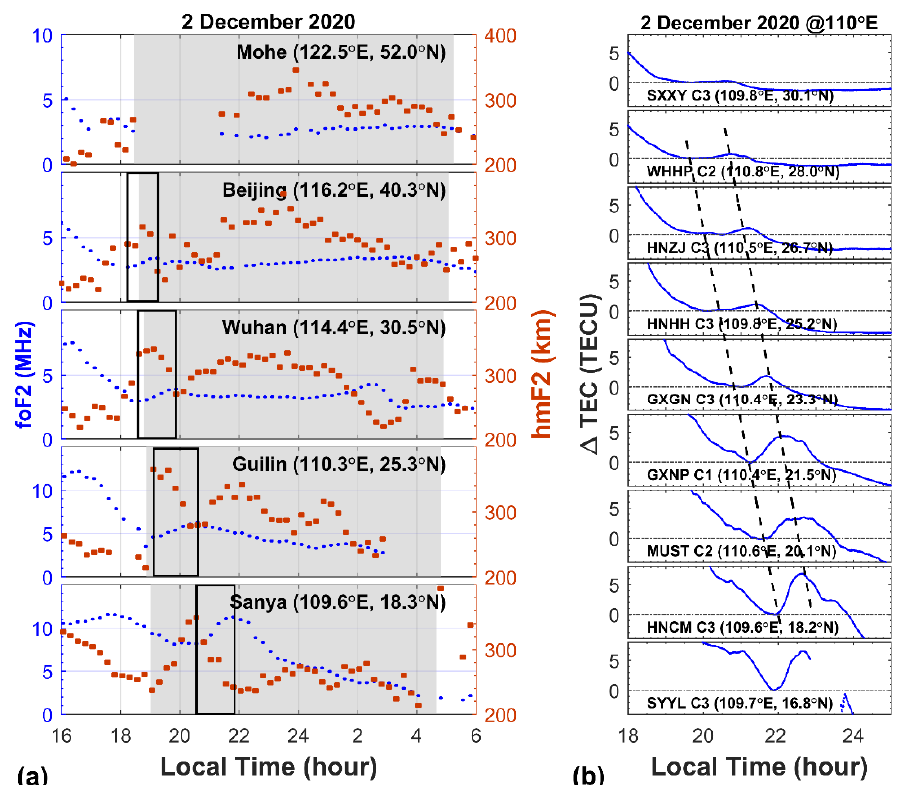
Figure 3. ( a ) Temporal variations of foF2 and hmF2 at Mohe, Beijing, Wuhan, Guilin, and Sanya within the time interval from 16 LT to 6 LT on 2–3 December 2020. The blue dots plot foF2, and the orange squares mark hmF2. In panels the gray-shaded area indicates local nighttime and black box frames out the developing phase of electron density enhancement. ( b ) Temporal variations of Δ TEC from 17 LT to 24 LT on 2 December 2020 at different latitudes along 110° E. Black dashed lines connect starting points and peak points separately.